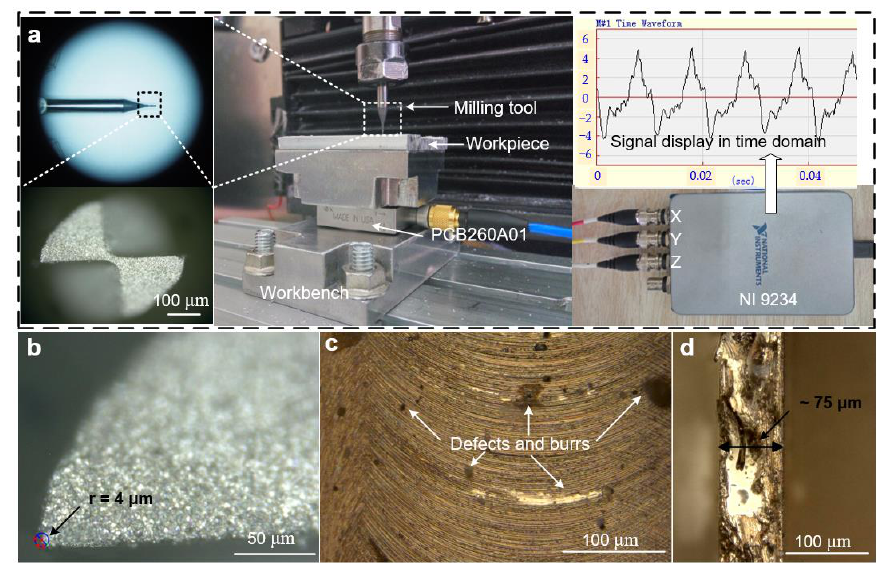
Figure 7. ( a ) Experimental setup and milling force measurement system; ( b ) measure the size of tool-edge radius and observe the tool geometry; ( c ) milled surface morphology and defects; ( d ) measure the thickness of micro thin-walled structure before and after processing from the top view.